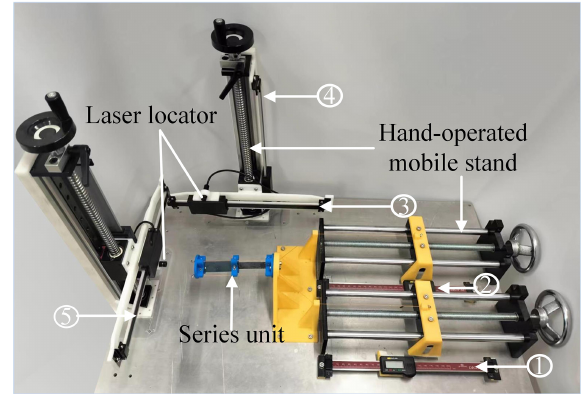
Figure 7. The verification test device of the series unit ( 1 (cid:13) , 2 (cid:13) , 3 (cid:13) , 4 (cid:13) , and 5 (cid:13) are the numbers of digital rulers).